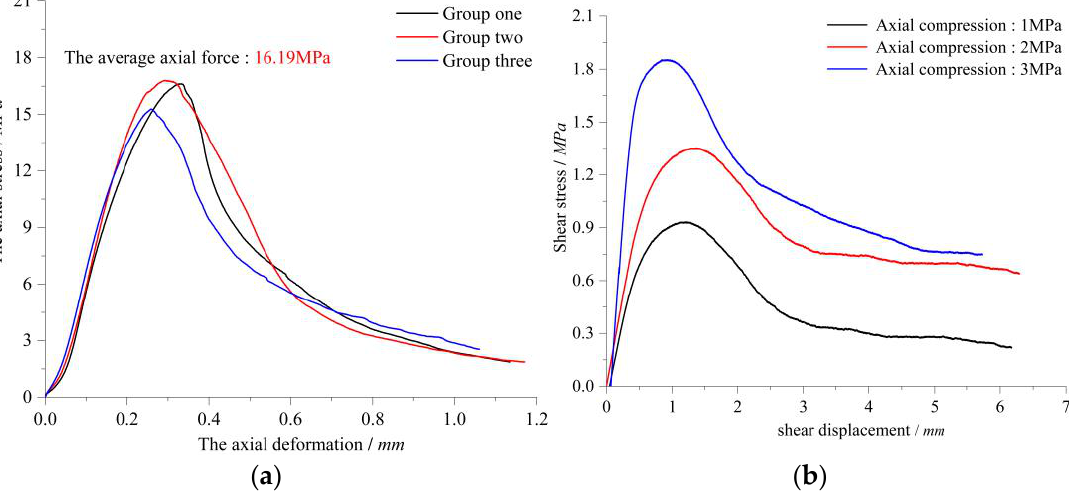
Figure 13. Comparison of failure evolution process. ( a ) Uniaxial compression curve; ( b ) direct shear curve.